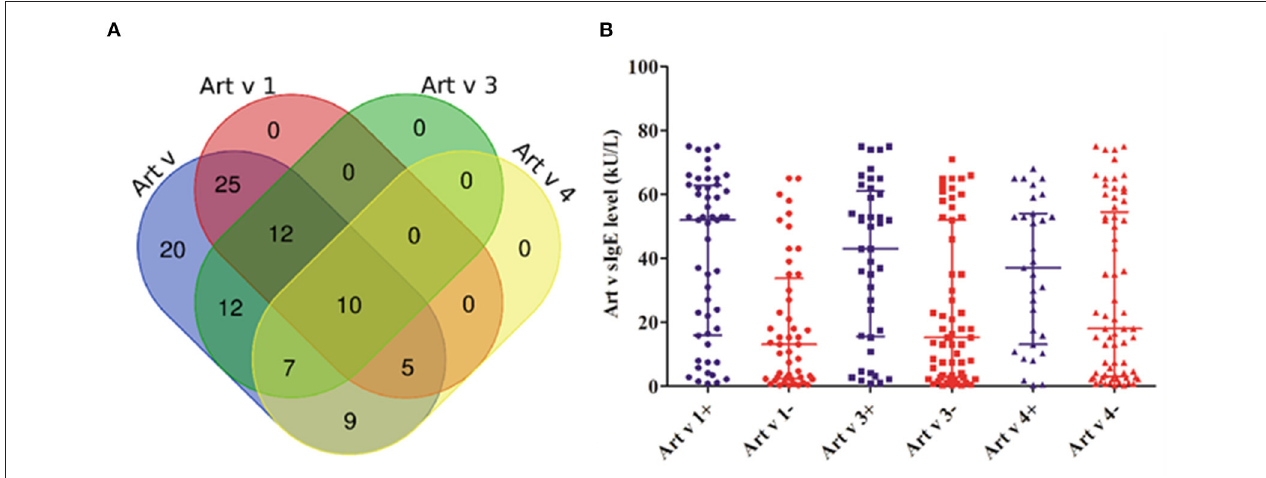
FIGURE 1 | The cosensitization of mugwort and its components. (A) The Venn diagram shows the number of patients what were cosensitized. (B) The comparison of different mugwort sIgE levels between positive ( + ) and negative (–) patients in Art v 1, Art v 3, and Art v 4.